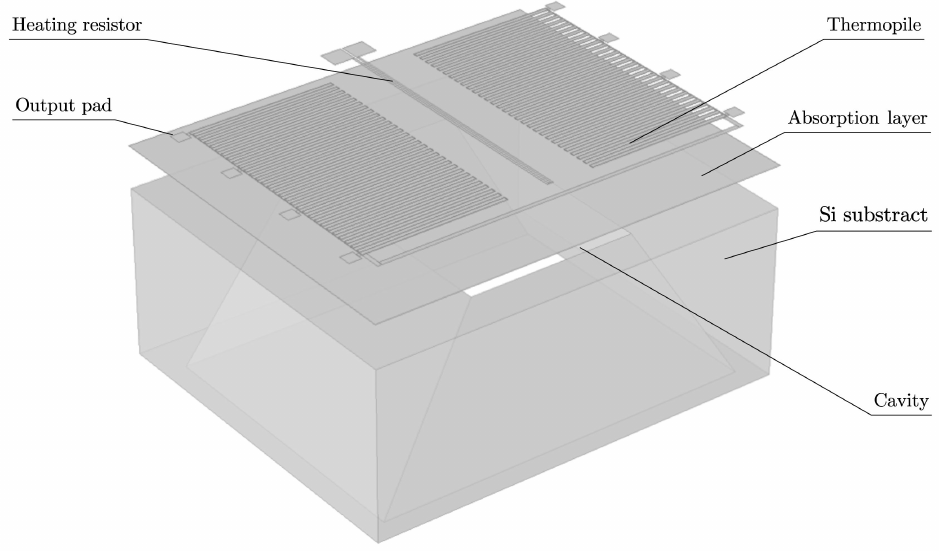
Figure 2. The closed-mode structure of infrared thermopile detector in this